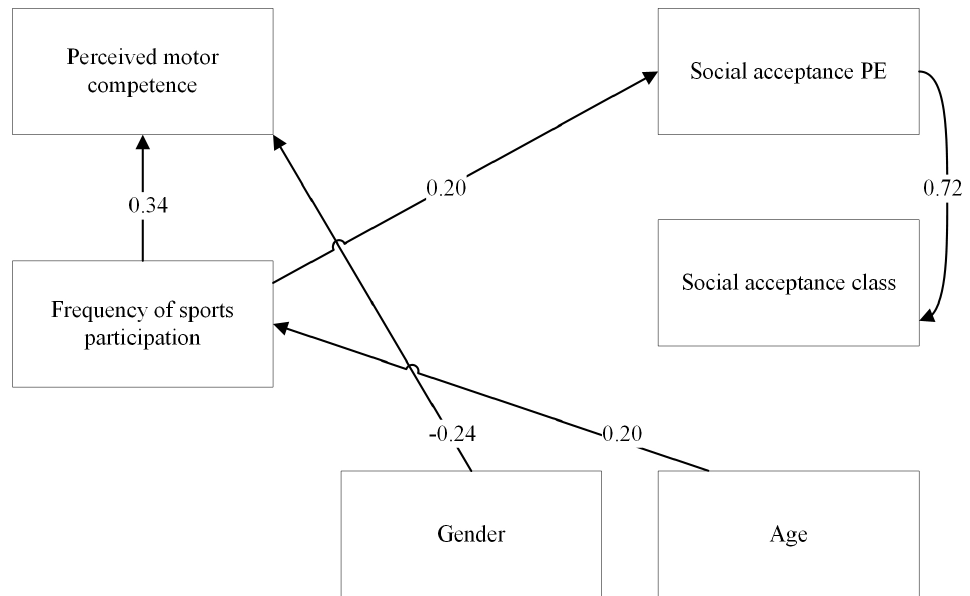
Figure 2. SEM model presenting significant paths between independent and dependent variables for children participating in team sports. Standardised path coefficients (betas) are presented in the figure.